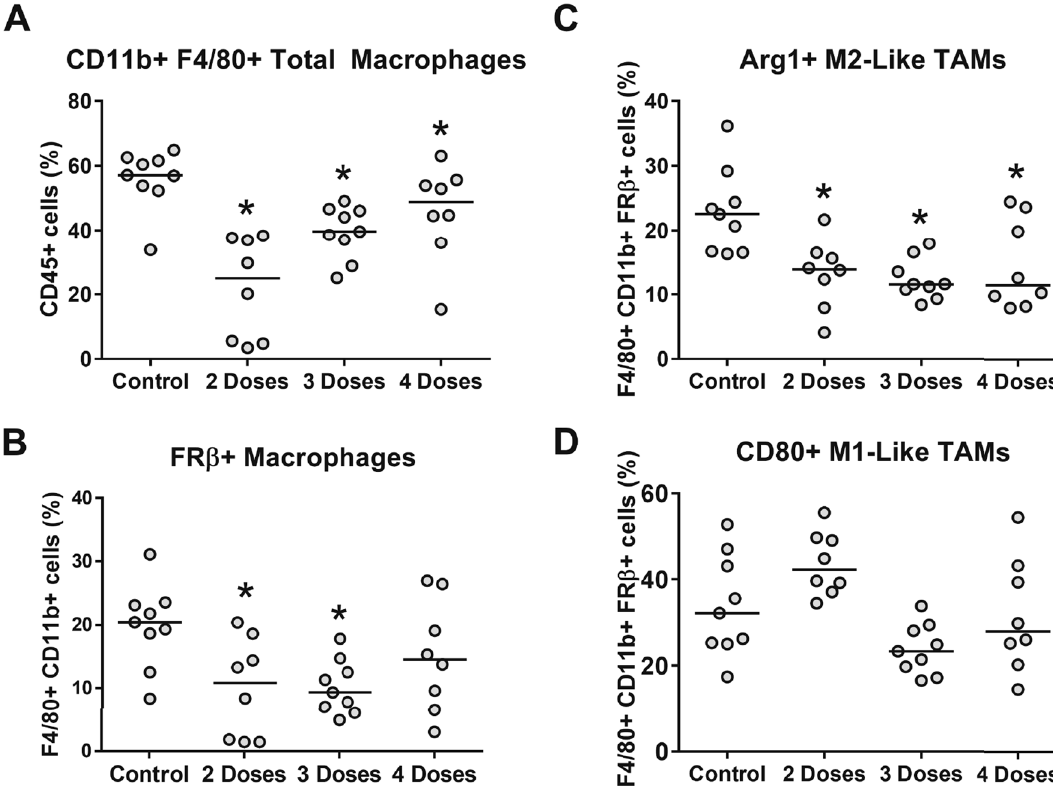
Figure 6. Impact of AGF94 treatment on tumor infiltrating macrophages. To assess the impact on the immune populations in mice treated with AGF94 , the immune populations from tumors and spleens were harvested after 2, 3, and 4 treatments. ( A ) Results are shown for the percentage of CD11b+ and F4/80+ macrophages. ( B ) Percentage of FRβ+, gated off CD11b+ and F4/80+ macrophages, are shown with 2, 3, or 4 doses of AGF94 . ( C ) Percentage of Arg1+ FRβ+, gated off CD11b+ and F4/80+ macrophages, are shown following 2, 3 and 4 doses of AGF94 . ( D ) Percentages of CD80+ FRβ+, gated off CD11b+ and F4/80+ macrophages, are shown following 2, 3, and 4 doses of AGF94 . Results are shown for individual mice. Horizontal bars represent median values. Statistical comparisons were made between AGF94 -treated and control groups. * p <